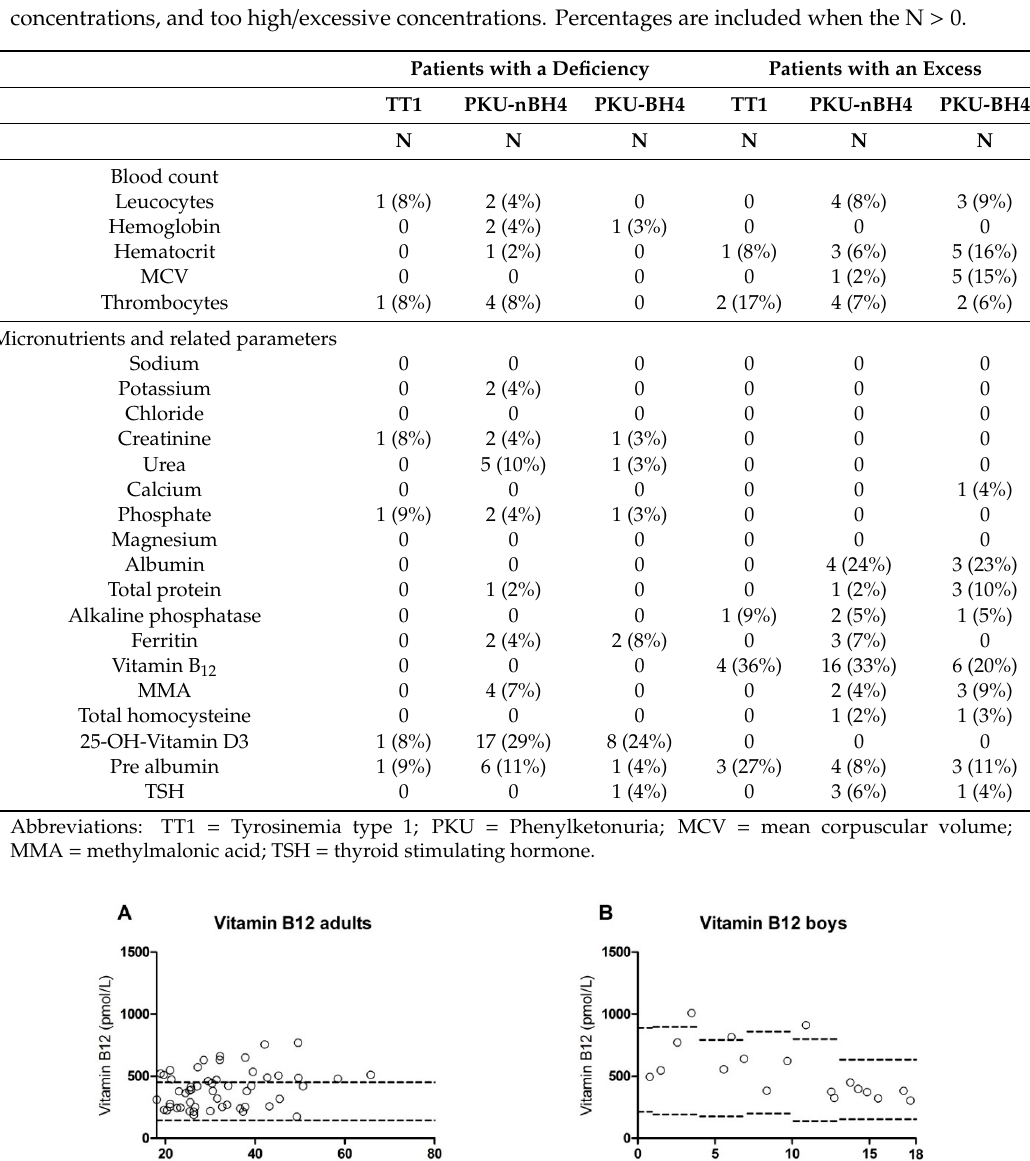
Table 2. Percentage of patients within the di ff erent patient groups with too low / deficient blood concentrations, and too high / excessive concentrations. Percentages are included when the N > 0.